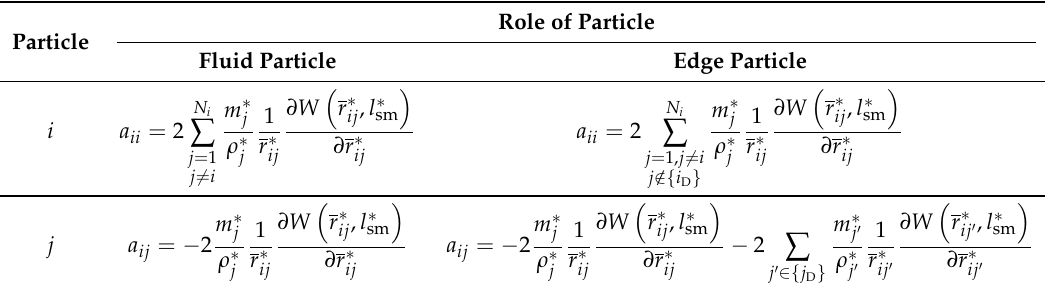
Table 1. Non-zero elements in matrix A of linear equation system corresponding to the pressure Poisson equation